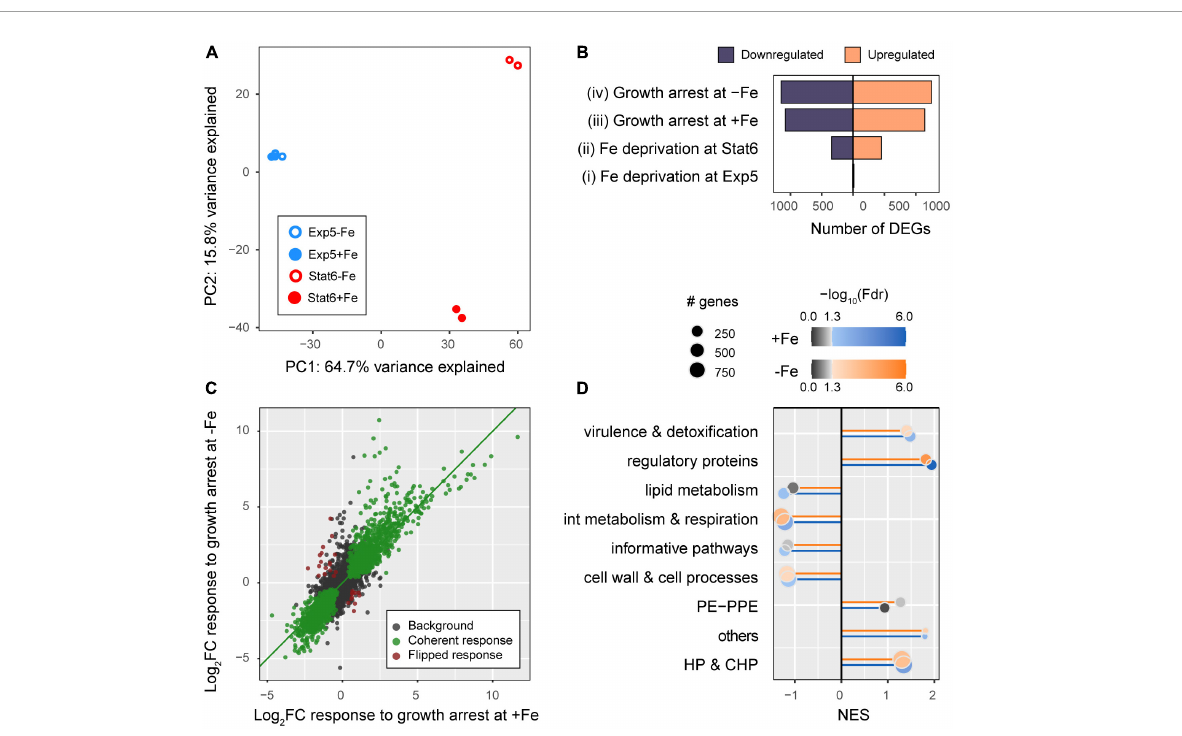
FIGURE3 Overall description of the dataset. (A) Principal component analyses (PCA) of log-counts per millions normalized across samples (see “Materials and methods”): PC1-growth phase; PC2-iron availability. (B) Number of DE genes that were upregulated (orange) or downregulated (blue) in the four comparisons made: iron deprivation at exponential phase Exp5 (contrast i) and at stationary phase Stat6 (contrast ii) as well as growth arrest (transition from Exp5 to Stat6) with iron (contrast iii), and without iron (contrast iv). See Figure 1 for further explanation. (C) Effect sizes of the changes in gene expression in response to growth arrest at +Fe ( x -axis) versus –Fe cultures ( y -axis). Highlighted in green and maroon colors, we show genes that were DE in both conditions (at FDR < 0.01), whose responses to growth arrest in –Fe and +Fe were directionally coherent (green), or flipped (maroon), and no DE (black). (D) Gene set enrichment analyses of genes annotated within Tuberculist functional